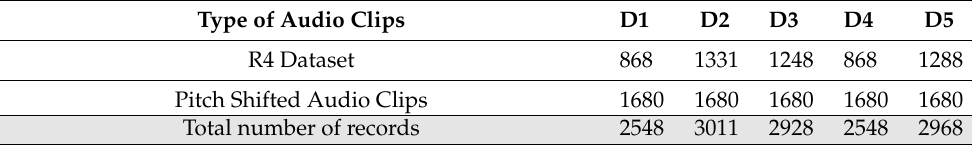
Table 4. Breakdown of R4A